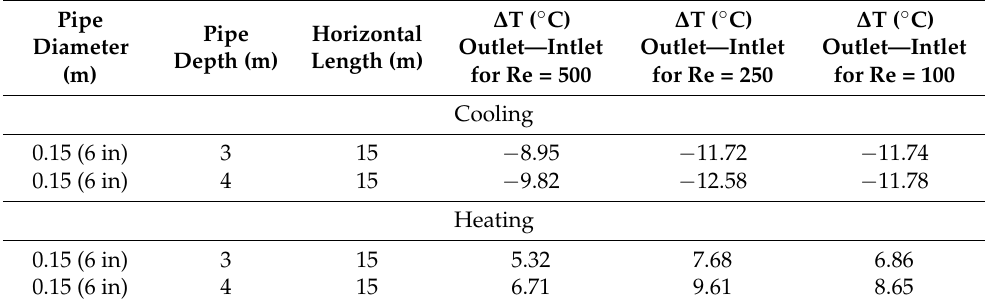
Table 12. Additional GAHE settings.